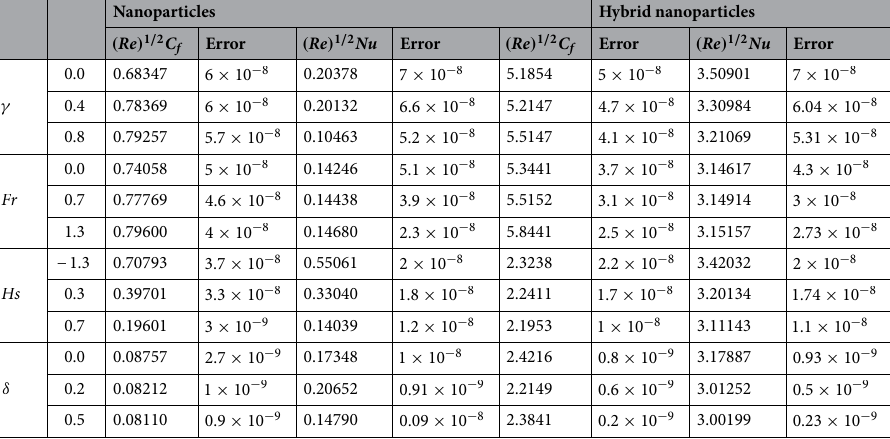
Table 4. Numerical values of − ( Re ) 1 / 2 Nu and − ( Re ) 1 / 2 C f versus γ , Fr , Hs and δ 21 when ε Pr = 204, (cid:31) = 1.3, ϕ 1